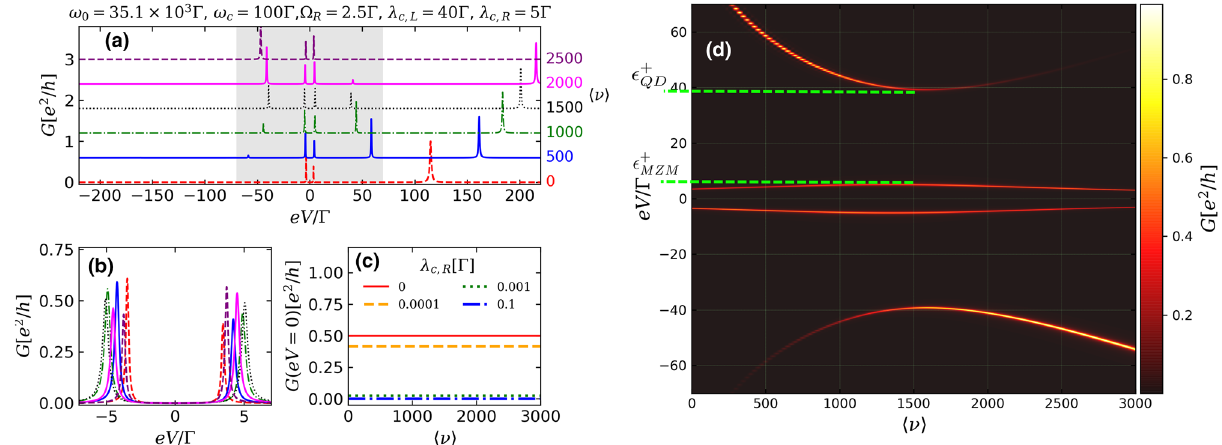
Figure 4. ( a ) Conductance through the QD [Eq. (6)] as a function of bias-voltage eV describing the case of ε M ) for increasing number of photon occupation MZMs with less degree of nonlocality ( (cid:31) c , R ≫ better viewing, the curves are offset along the y axis. ( b ) Same curves depicted in ( a ), but considering eV only near zero-bias without offset along y axis. ( c ) Conductance through the QD at zero-bias eV ν number of considering distinct values of (cid:31) c , R . ( d ) Colormap showing the conductance behavior as a function (cid:31) (cid:30) ν of both the eV and , for a range of eV corresponding to gray region of ( a ). Dashed light-green lines indicate (cid:31) (cid:30) the energies ǫ + QD and ǫ + MZMs of anticrossing points employed to estimate the degree of Majorana nonlocality /ǫ + QD , as proposed by Prada et al. 32 . For the data shown in ( d ), (cid:31) M � 2 M ǫ + MZMs =